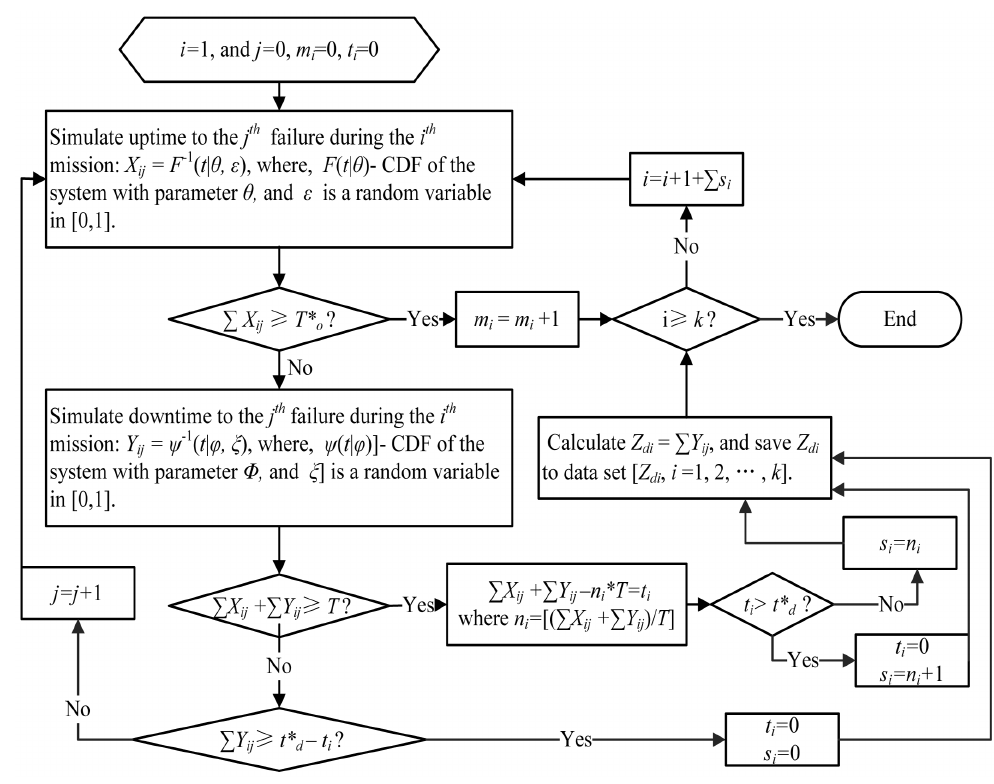
Figure 4. MC simulation procedure of mission dependence.